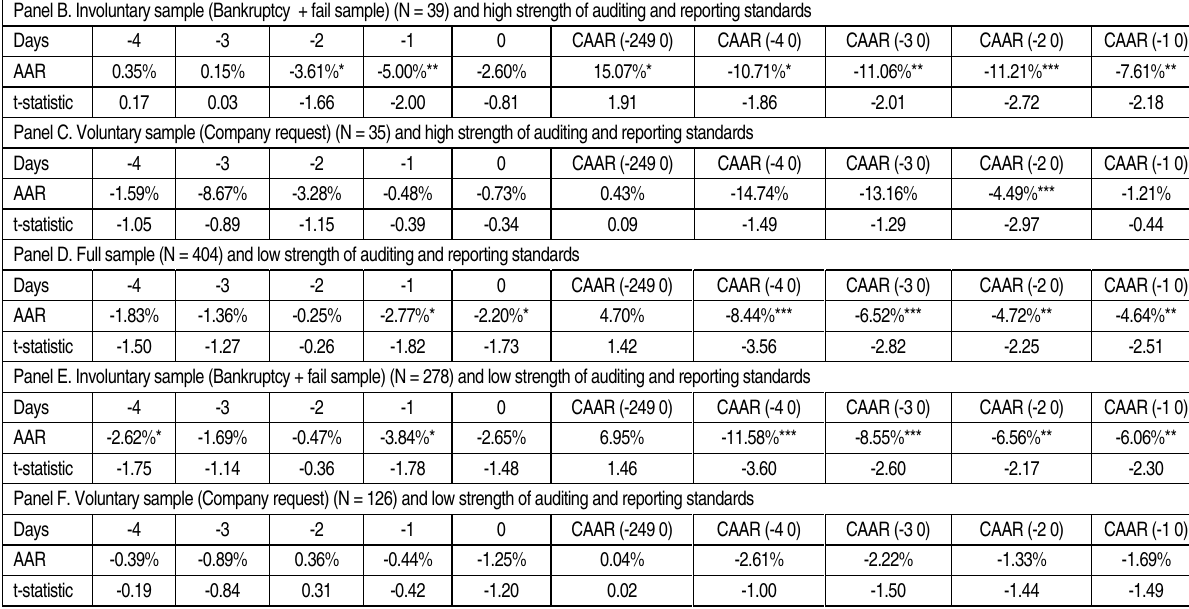
Table 3 (cont.). Average abnormal returns and cumulative average abnormal returns around delistings an- nouncement days, based on the strength of auditing and reporting standards